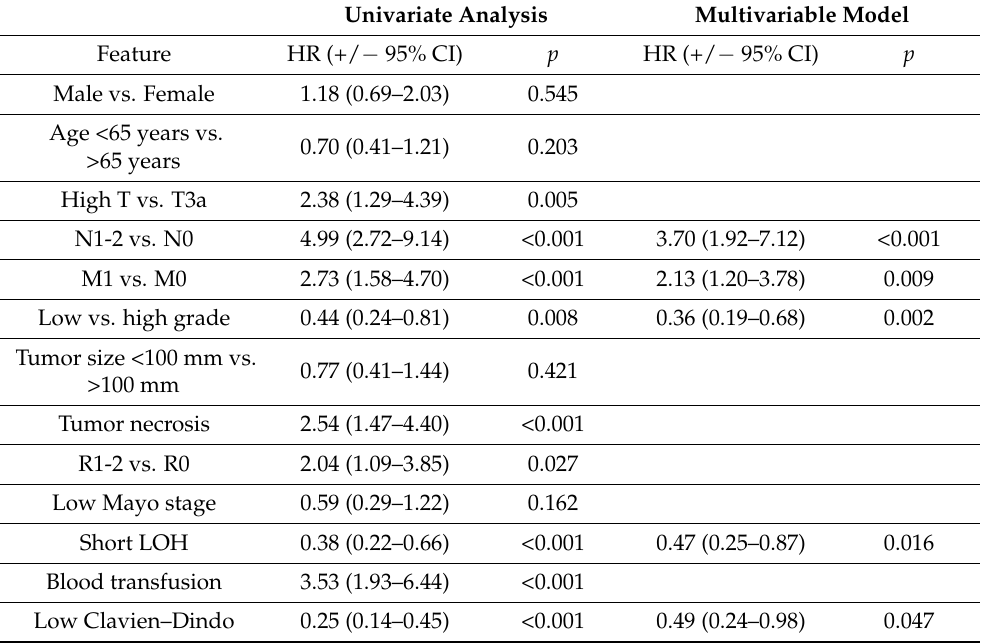
Table 2. Characteristics of the univariate analysis and multivariable Cox regression model. Abbrevia- tions and explanations: high T: tumor ≥ T3b; high grade: ≥ G3; low Mayo stage: 0–1; LOH: length of hospitalization; short LOH: ≤ 9 days; low Clavien–Dindo: grade I. Univariate Analysis Multivariable